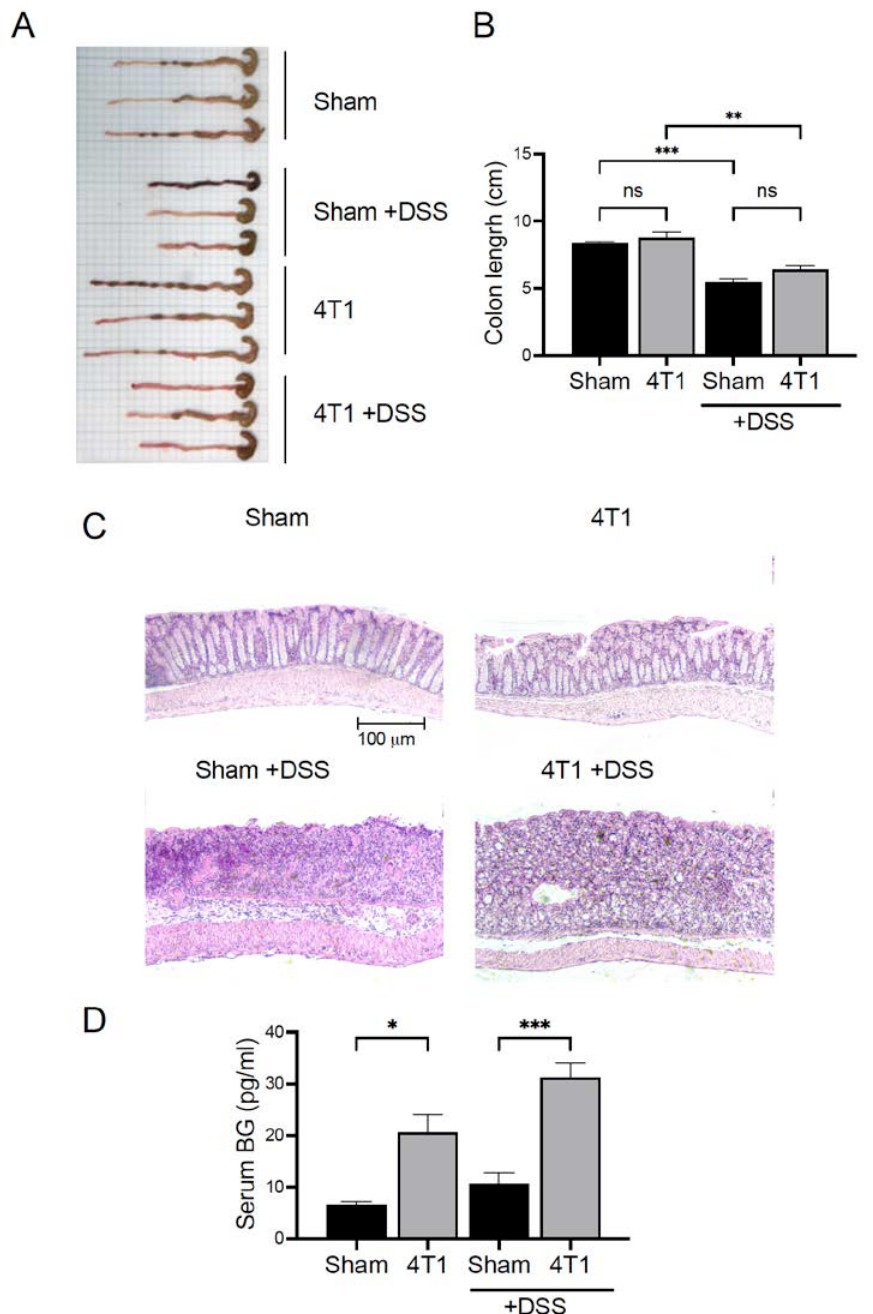
Figure 6. Gastrointestinal permeability barrier defects in 4T1 tumor mice as determined by serum (1 → 3)- β -D-glucan. 4T1 cells were transplanted subcutaneously into the right flank of a 6-week-old female mouse. ( A ) The picture of colon of the mice at day 21 and ( B ) the bar graph show the colon length. ( C ) H&E histology of the colon tissue sections. ( D ) The serum (1 → 3)- β -D-glucan levels were detected by ELISA. Data are from one experiment representative of three independent experiments. All data are presented as mean ± SEM and assessed with a Mann–Whitney U test. * p < 0.05; ** p < 0.01; *** p < 0.005; ns = not significant.